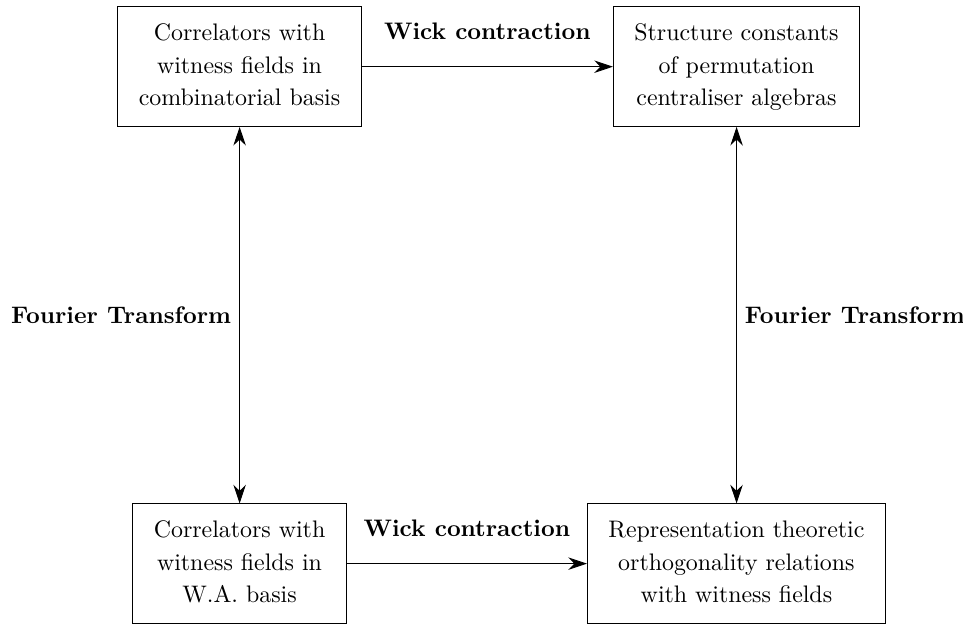
Figure 1 . The diagram demonstrates the core results of the paper. The action of Fourier trans- forming exchanges combinatorial and Wedderburn-Artin (W.A.) bases, while Wick contractions are used to produce the orthogonality relations of correlators as well as the structure constants of the associated